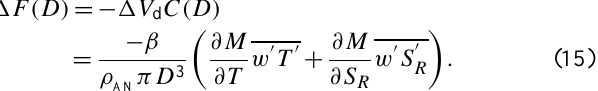
Figure 8. The distribution of distribution shown in Fig. 2. 3